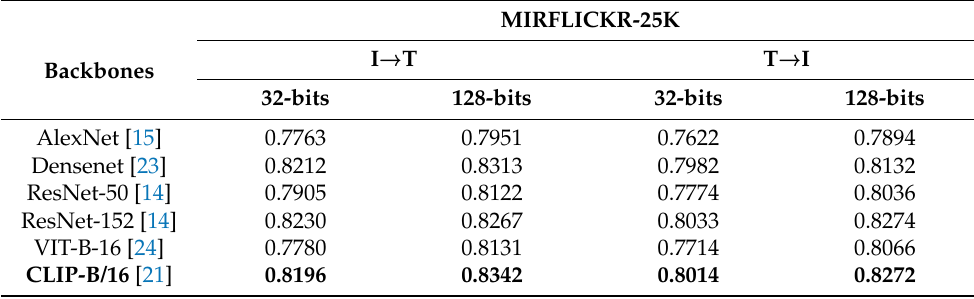
Table 6. The MAP@5000 of the proposed CAGAN with different backbone networks on the MIRFLICKR-25K